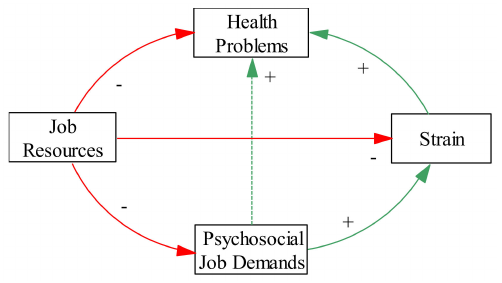
Figure 3. The Conservation of Resources (COR) model (adapted from Mayerl et al., 2016 [14]). Note: green arrows indicate positive causal relations, and red arrows indicate negative causal